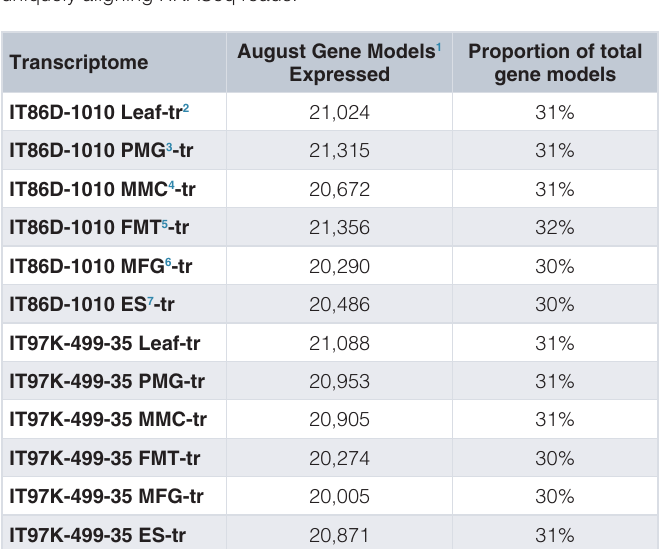
Table 8. Proportion of predicted gene models that accrue RNA sequencing reads. Counts shown for gene models with more than 20 uniquely aligning RNASeq reads.